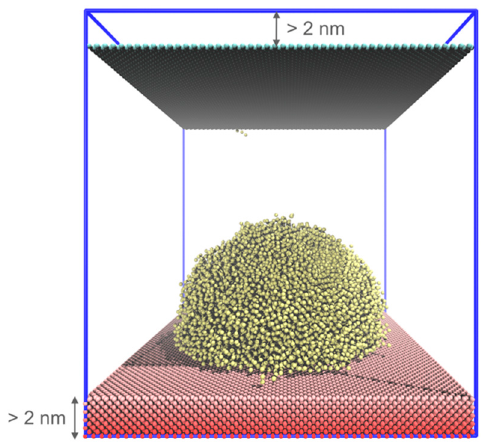
Figure 4. Simulation box set-up (blue) where a flat surface structure SS_0 is used as an example. n-decane molecules (yellow) are initially placed in a cubic arrangement (not shown) in the middle of the simulation box, between the solid surface structure (red) and the top repulsive barrier (green). During the simulation, the fluid forms a drop and adsorbs on the surface, equilibrating in the form of a droplet. The surface thickness and the space above the barrier is designed to be greater than the 2-nm potential cut-off to prevent interactions between periodic images.